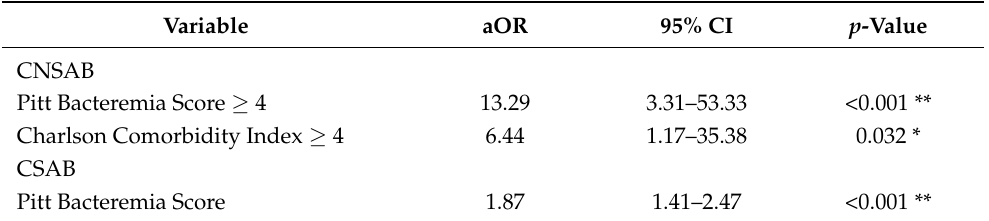
Table 5. The final model of multivariate analysis showing determinant of death of bacteremia due to CNSAB ( n = 41) and CSAB ( n =